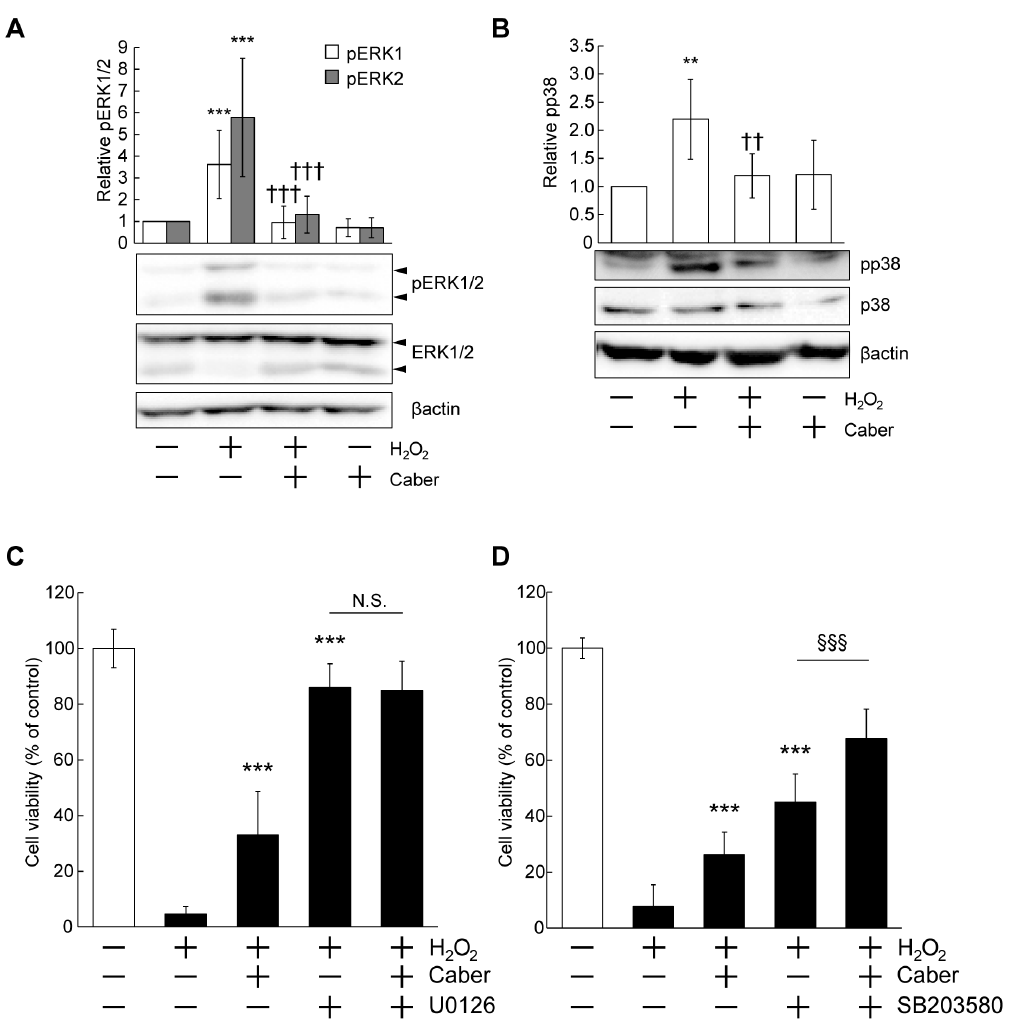
Figure 4. Cabergoline reduced death signaling by H 2 O 2 . (A) (B) Pretreatment of cabergoline inhibited H 2 O 2 -induced activation of ERK1/2 and p38. Cabergoline was added at 10 m M. After 24 hours, cortical neurons were exposed to H 2 O 2 (50 m M) for 1 hour (pERK1/2) or 30 min (pp38), followed by western blotting. The membranes were stripped, and re-blotted with anti-total ERK1/2 and p38 antibodies. Upper : Quantification of phosphorylated ERK1/2 or p38 levels. All data represent mean 6 SD (pERK1/2: n=7, pp38: n=5). *** P , 0.001, ** P , 0.01 vs. - H 2 O 2 - Caber, {{{ P , 0.001, {{ P , 0.01 vs. + H 2 O 2 - Caber (two-way ANOVA). (C) Co-treatment of cabergoline and U0126 had no additive effect on neuroprotection. U0126 (10 m M) was added 20 min before cabergoline (10 m M) treatment, followed by MTT assay. The data represent mean 6 SD (n=9–12). *** P , 0.001 vs. + H 2 O 2 - Caber - U0126 (three-way ANOVA). (D) Co-treatment of cabergoline and SB203580 showed a significant additive effect. SB203580 (10 m M) was added 20 min before cabergoline (10 m M) treatment. The data represent mean 6 SD (n=9–12). *** P , 0.001 vs. + H 2 O 2 - Caber - SB203580